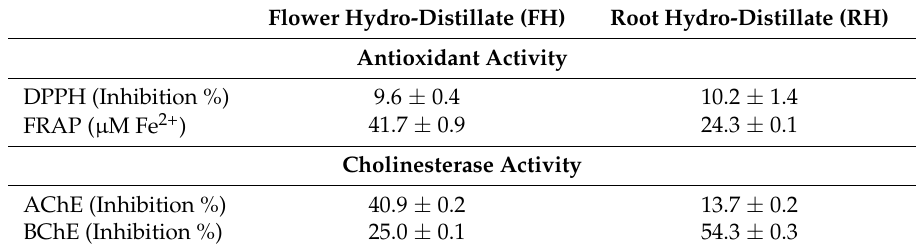
Table 3. Antioxidant and cholinesterase inhibitory activity of volatile isolates from Bunias erucago. Flower Hydro-Distillate (FH)